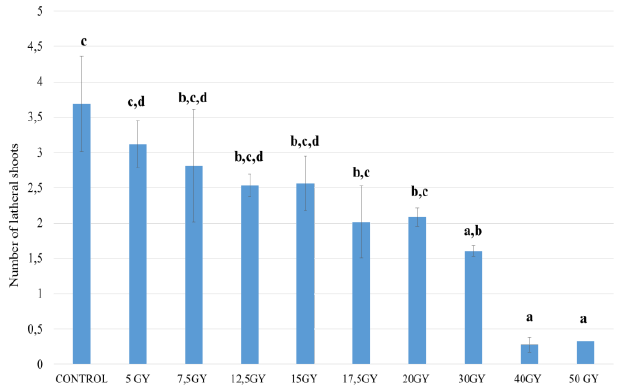
Figure 6. Number of lateral shoots of the plants at different doses of radiation